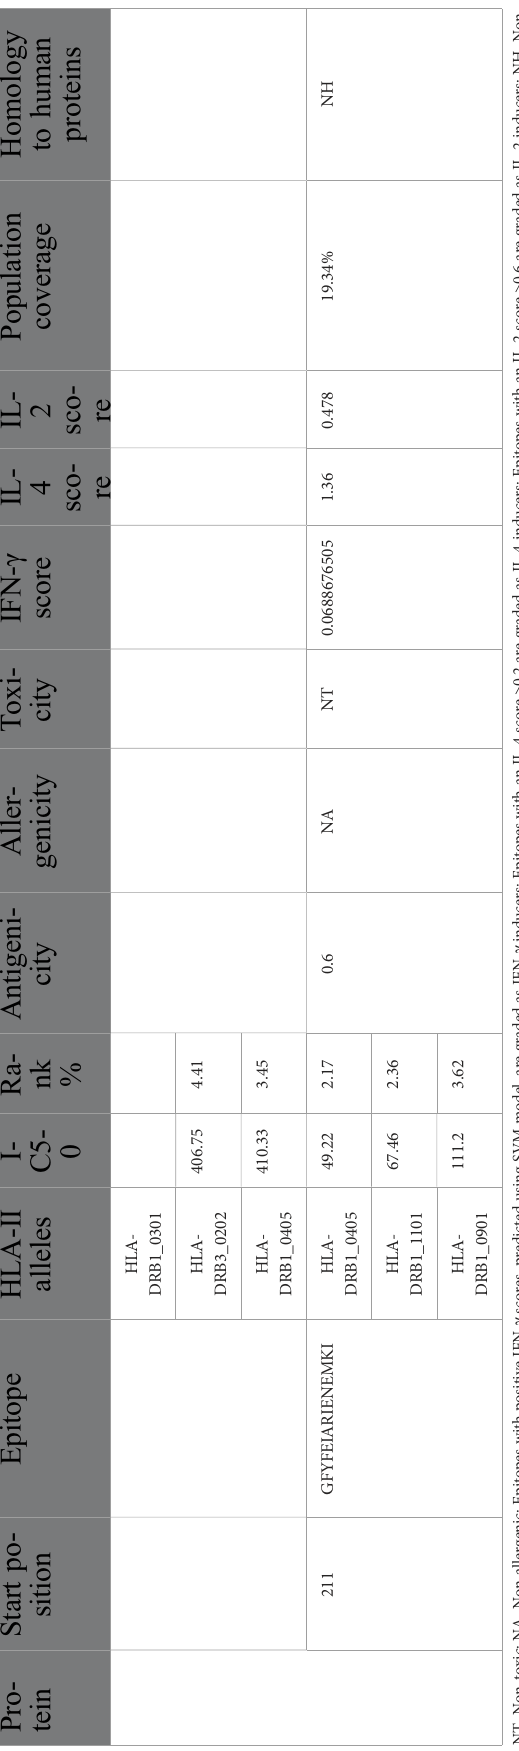
allowed region, and only 1.2% of residues in the disallowed regions the re fi ned 3D models of the MPXV-2 and MPXV-5 vaccine constructs.